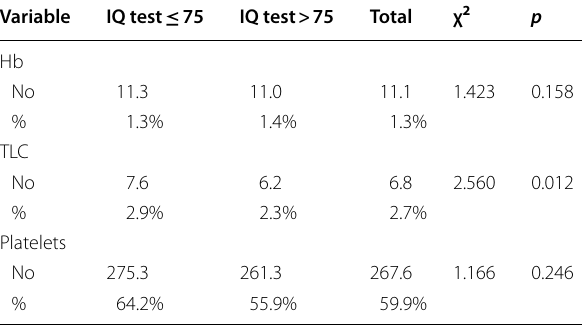
Table 5 Distribution of laboratory data according to IQ